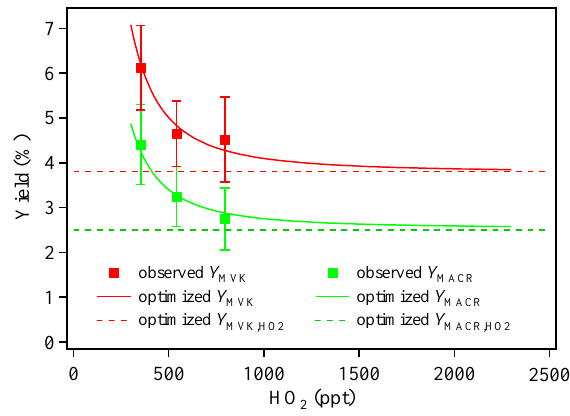
and Y MACR,HO using the yield 2 2